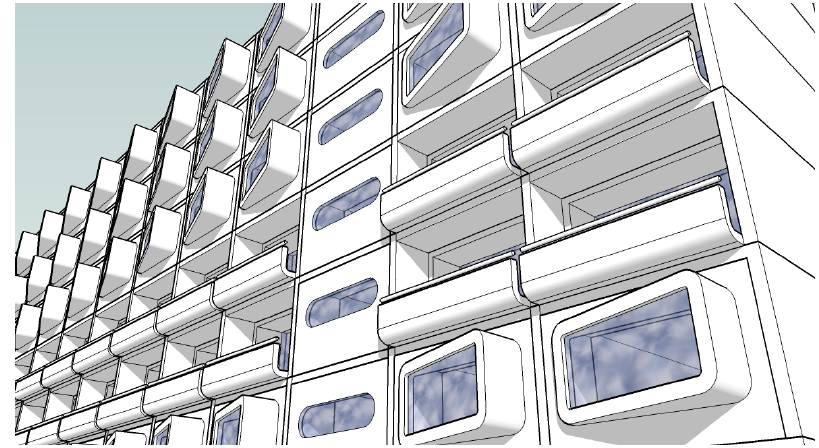
Figure 3: Example of the variety of design and